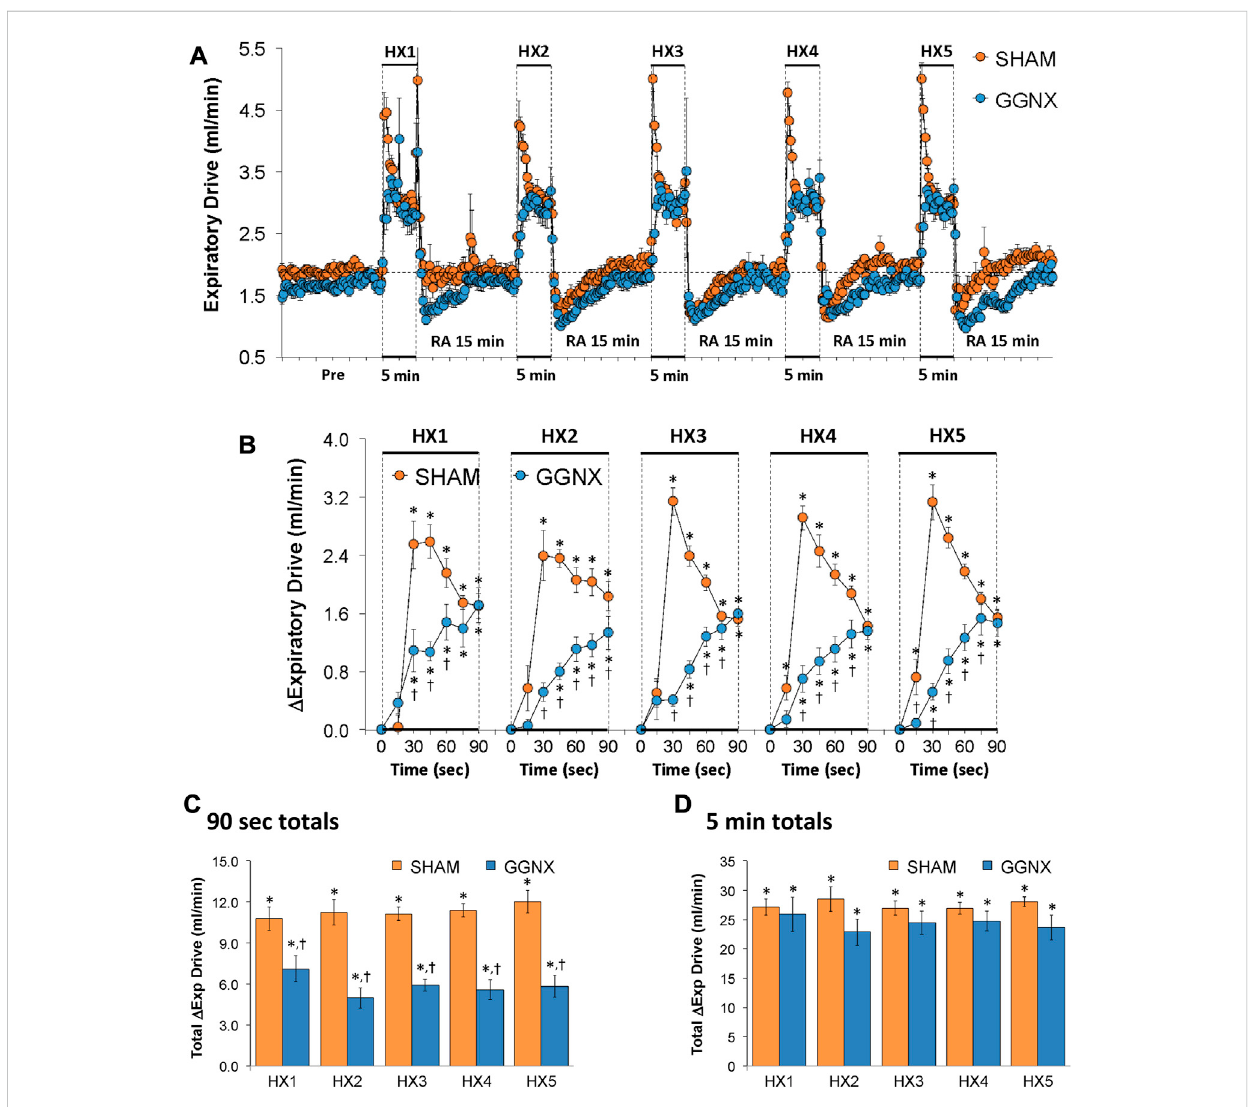
FIGURE 13 (A) Expiratory Drive (Exp Drive) values in sham-operated (SHAM) rats and in rats with bilateral ganglioglomerular nerve transection (GGNX) before (Pre) and during fi ve hypoxic (HX, 10% O 2 , 90% N 2 ) gas challenges, each separated by 15 min of room-air (RA). (B) Arithmetic changes in Expiratory Drive during the fi rst 90 s of HX gas challenge. Total changes in Expiratory Drive during the fi rst 90 s (C) and over the entire 5 min (D) of HX gas challenge. The SHAM group had 10 rats. The GGNX group had 12 rats. The data are presented as mean ± SEM. * p < 0.05, signi fi cant response. † p < 0.05, GGNX rats versus SHAM